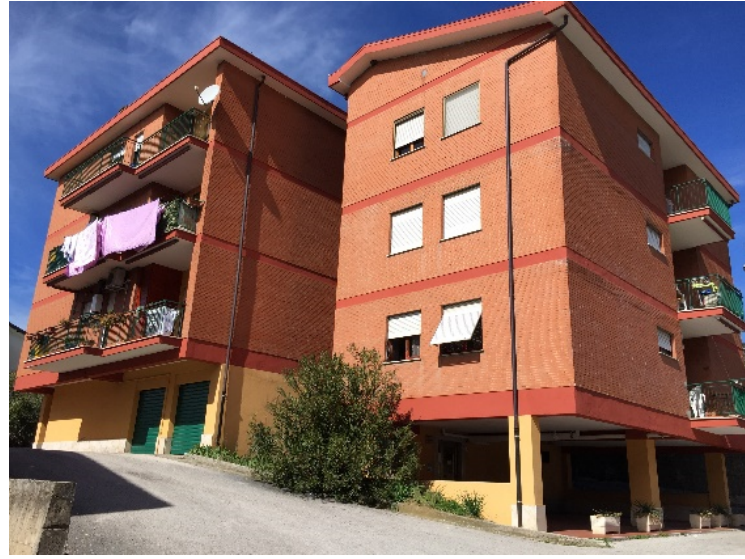
Figure 2. Picture of the building case-study.